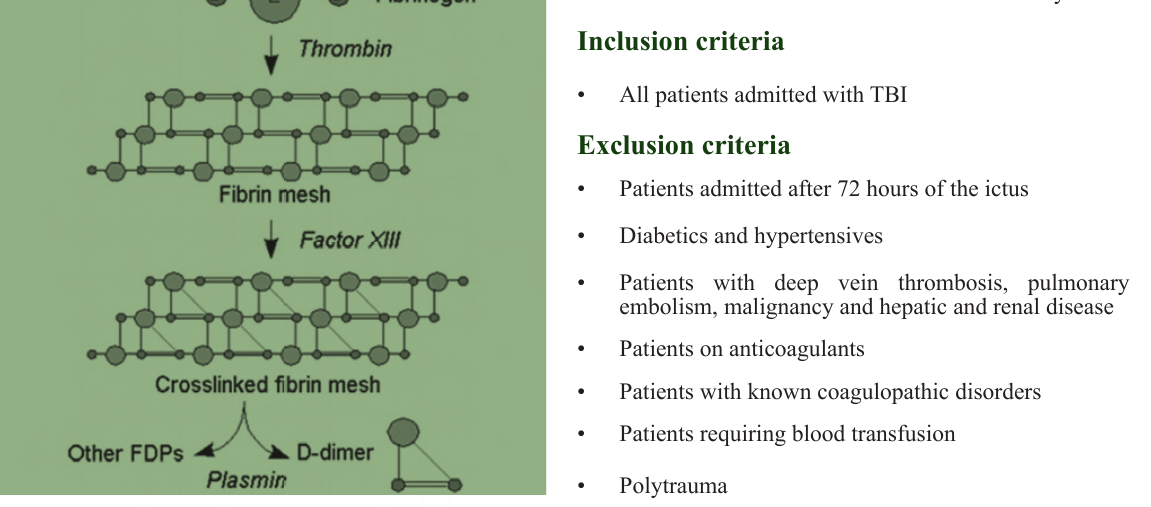
Figure 1: Formation of D-dimer 45